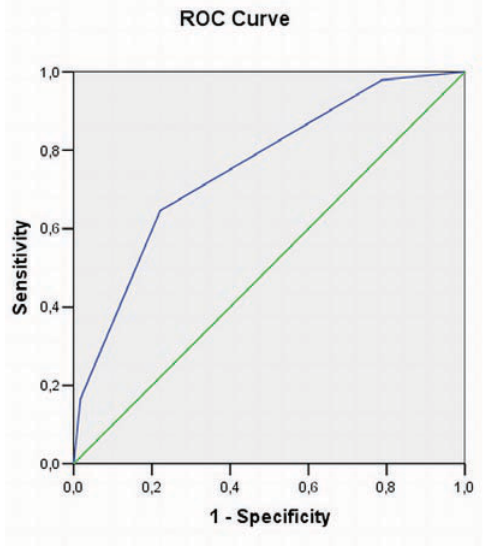
Figure 3. The accuracy of US examination for the diagnosis of at least moderate